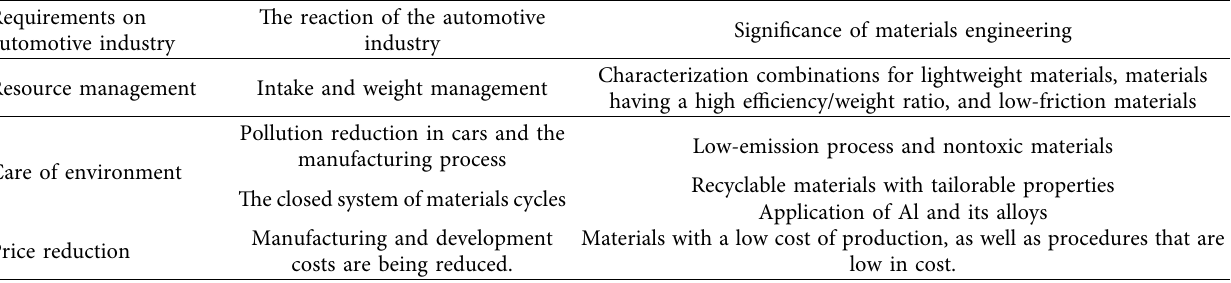
Table 11: Future material requirements in the automobile industry [133].